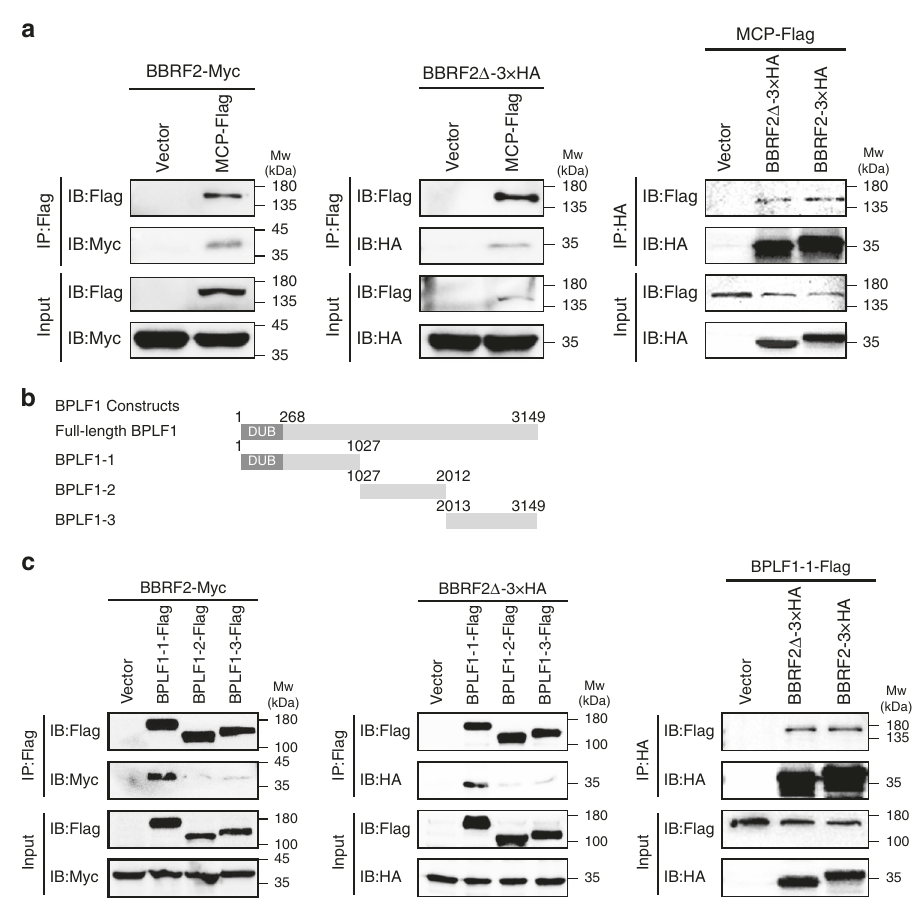
Fig. 6 BBRF2 binds MCP and capsid-associated BPLF1. a Reciprocal co-IP of EBV MCP and BBRF2/BBRF2 Δ in HEK293T cells. Empty vectors were used as negative controls. IB immunoblotting; Input, whole cell lysis. Source data are provided as a Source Data fi le. b Truncated versions of BPLF1. Residue numbers are indicated at the borders. DUB deubiquitination (DUB) domain. c Co-IP of BPLF1 fragments and BBRF2/BBRF2 Δ . The association between BPLF1-1 and BBRF2/BBRF2 Δ was further veri fi ed by a reciprocal co-IP test. Source data are provided as a Source Data fi le. Each experiment was repeated three times independently with similar